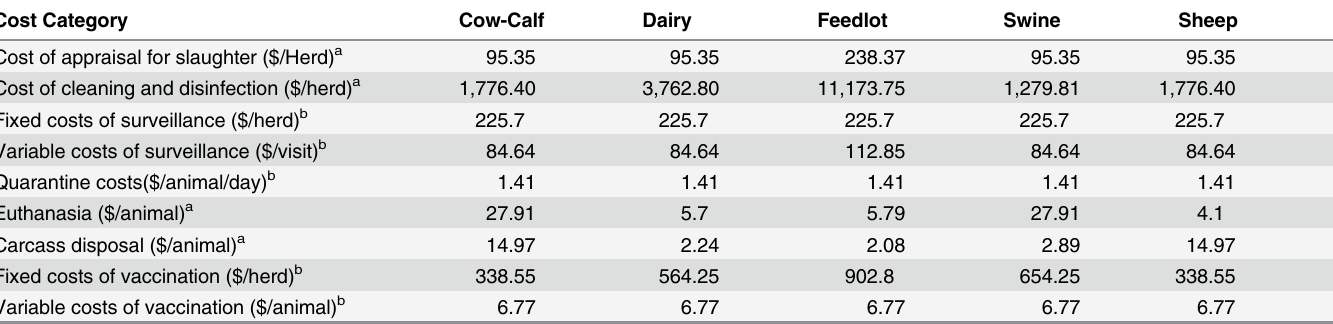
Table 2. Government Costs used in Mitigating and Eradicating an FMD